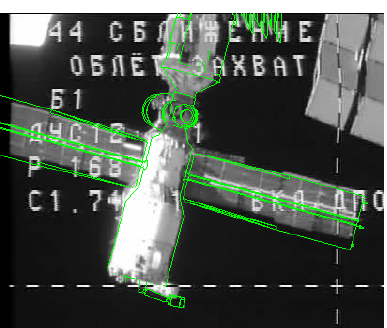
Figure 7. Recovered orientation angle ϕ